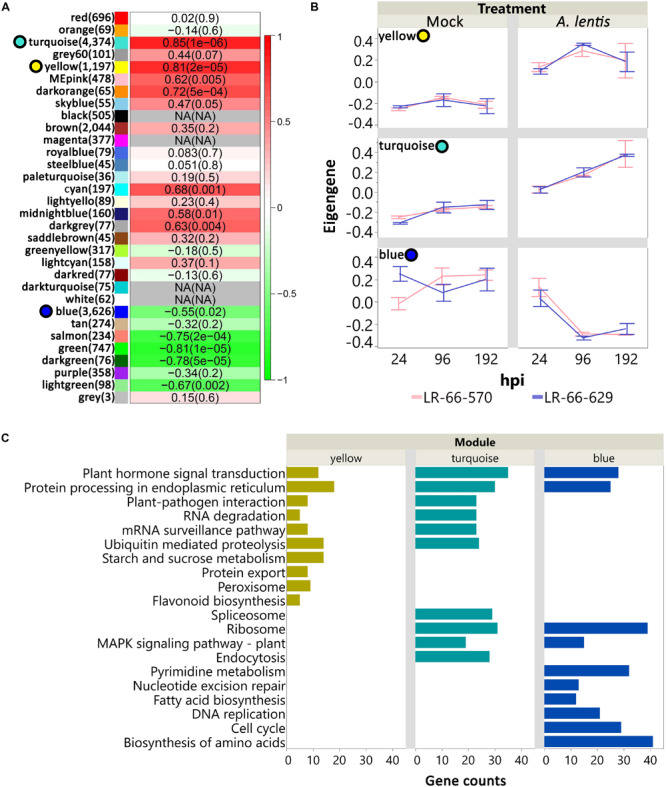
Analysis of consensus networks of gene expressions in mock or Ascochyta lentis- infected tissues of Lens ervoides RIL LR-66-570 (susceptible) and LR-66-629 (resistant). (A) Correlation between module eigengenes and treatment (mock or A. lentis-inoculated). Modules are arbitrarily identified by color names. Number of genes for each module is shown in parentheses to the right of the module name. Correlation coefficient and P value for each module is shown inside of heatmap. A P value cutoff of 0.01 was set to declare significant modules. Top three significant, major modules (yellow, turquoise, blue) are highlighted with colored circles to the left of module name. (B) Time-series gene expression of yellow, turquoise, and blue for mock and A. lentis-inoculated RILs. Value of eigengene represents the overall gene expression of that module. Error bars represent standard errors of the means. (C) Top significant KEGG terms enriched in yellow, turquoise, and blue modules. The vertical axis indicates the significant KEGG terms and horizontal axis represents gene counts for each KEGG term. An adjusted P value of less than 0.05 was set to declaring significant KEGG terms.